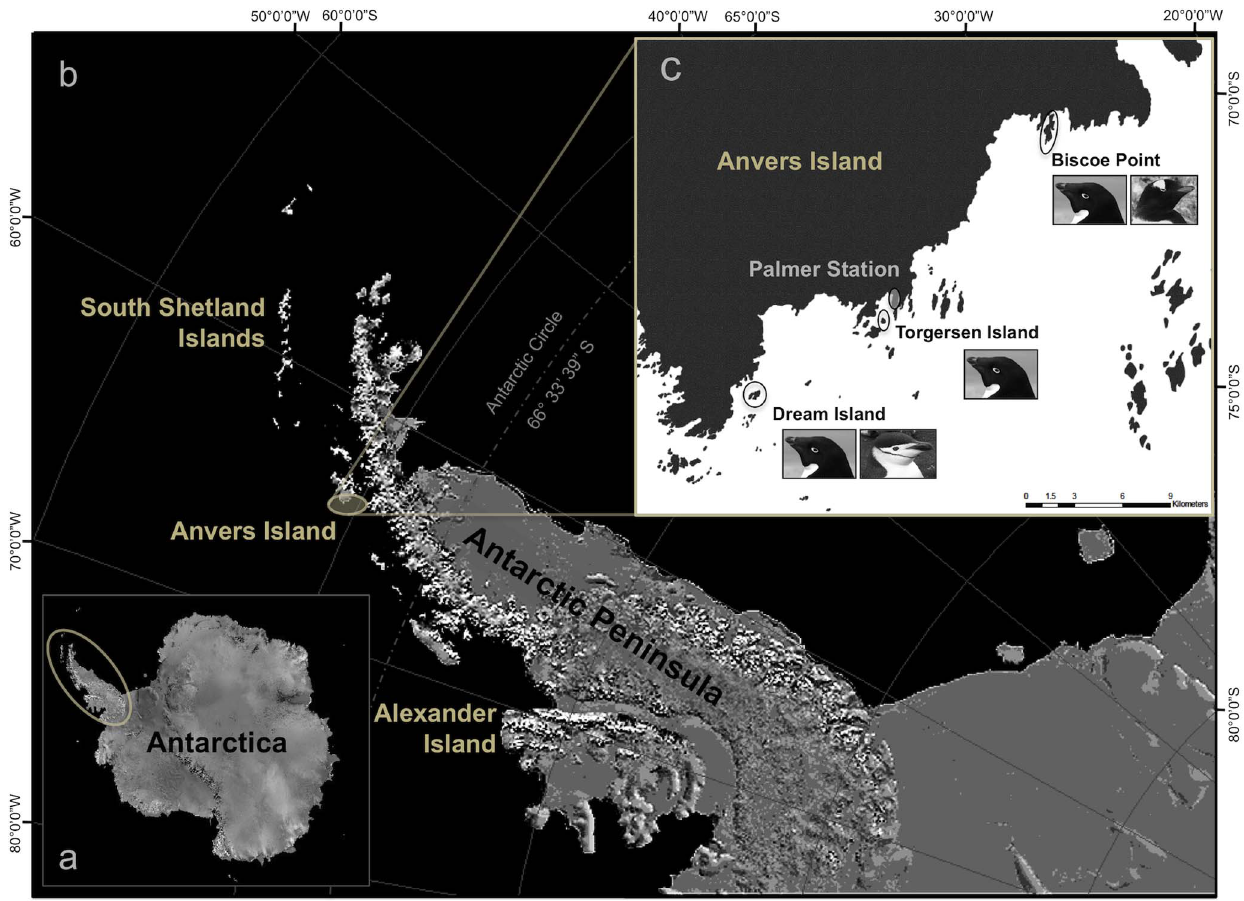
Figure 1. The marine ecosystem west of the Antarctic Peninsula (a) extends from northern Alexander Island to the South Shetland Islands (b). Fieldwork for the present study took place within the Palmer Archipelago near Anvers Island and Palmer Station, a United States supported research base (b, c). Penguin rookeries were located at Dream [Ade´lie and chinstrap], Torgersen [Ade´lie only], and Biscoe [Ade´lie and gentoo] Islands (c). Image generated from base maps provided by the National Snow and Ice Data Center’s map server A-CAP (http://nsidc.org/agdc/ acap/).